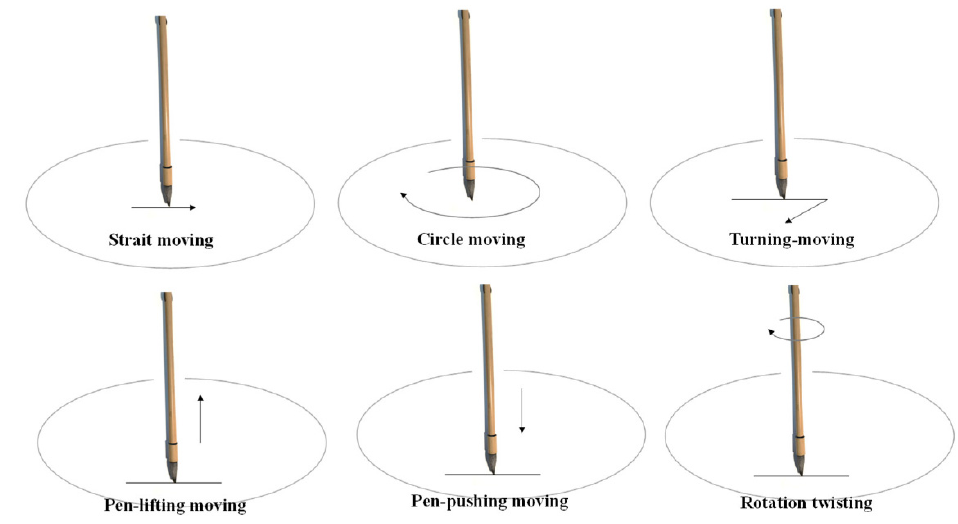
Figure 3. Illustration of six brushwork